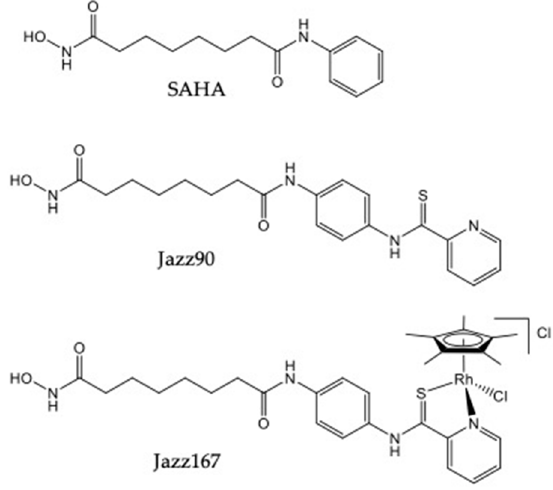
Figure 1. Structures of SAHA, Jazz90, and Jazz167.